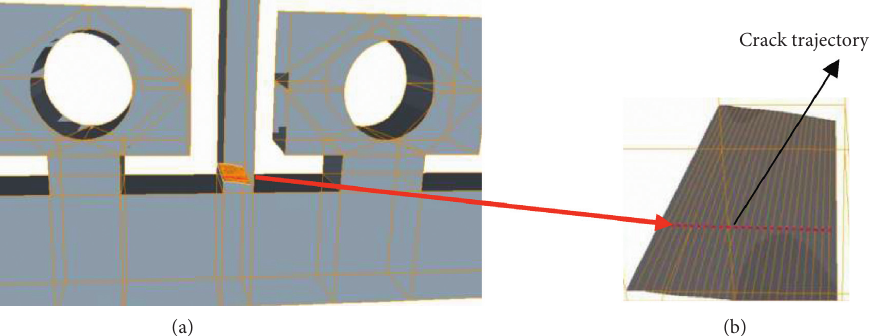
Figure 14: Crack in the fixture. (a) Cross section of the crack. (b) Partial enlarged figure of the crack